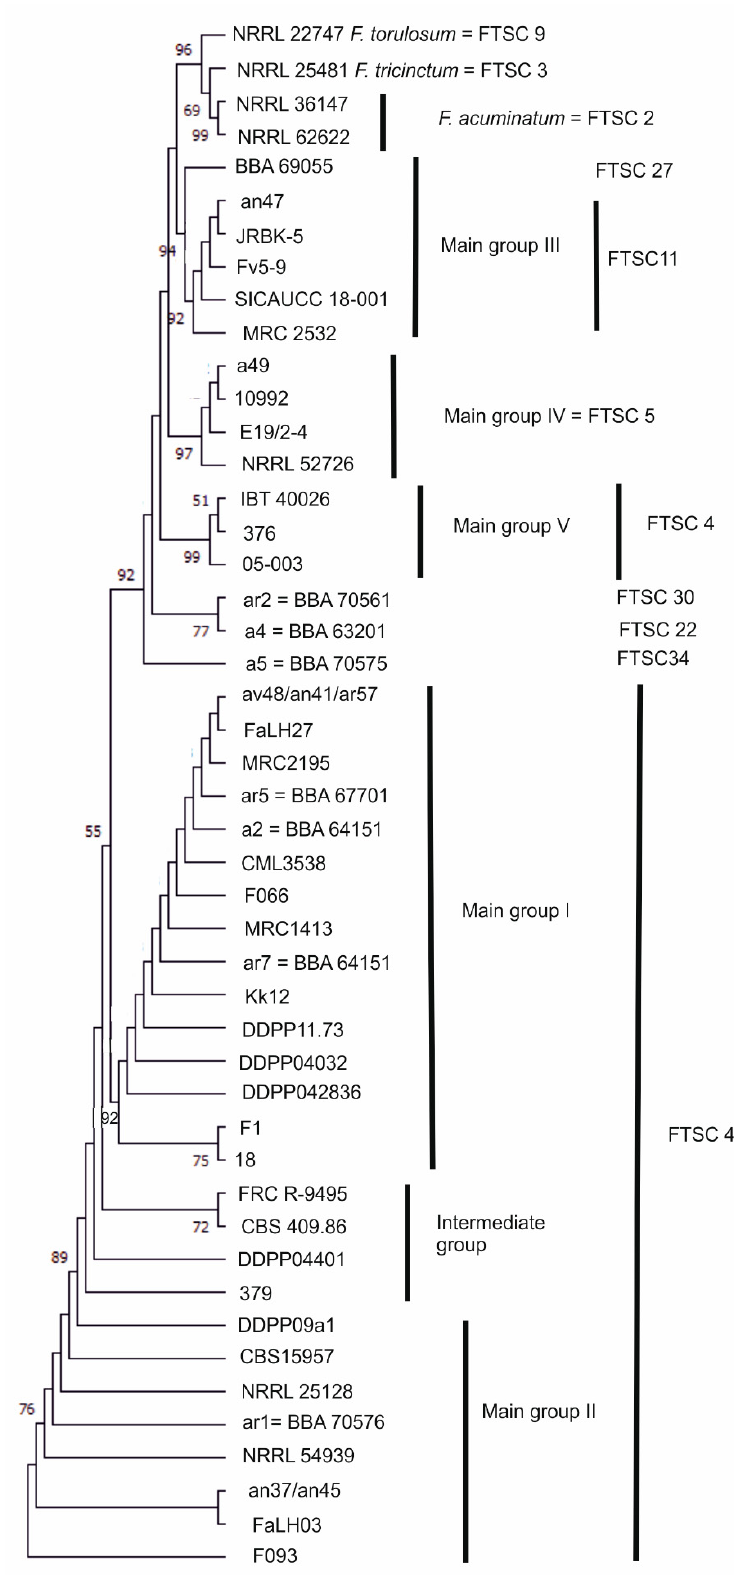
Figure 2. Maximum-parsimony consensus tree of translation elongation factor 1-alpha ( TEF1 ) se- quences, including strains from the work of Kulik et al. [32] (2011). Bootstrap values are indicated above nodes based on 500 pseudoreplicates of the data. Only branches present in more than 50% of the trees are shown. Fusarium tricinctum and F. acuminatum strains are